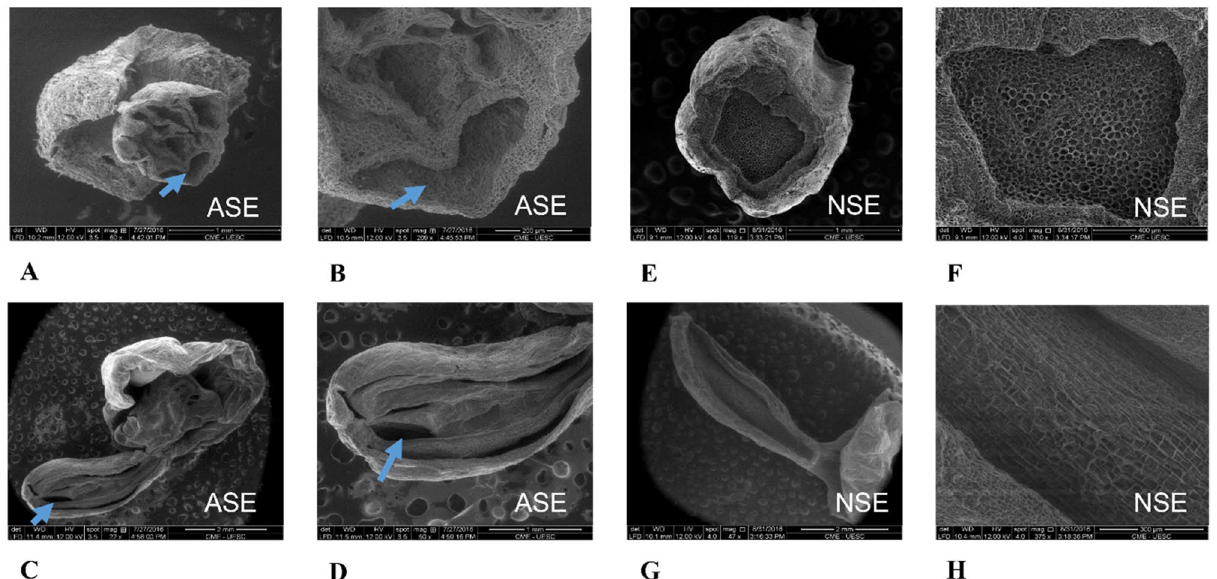
Figure 2. Morphological comparison between normal and abnormal somatic embryos. Scanning electron microscopy of AT4 SE transverse ( A,B ) and longitudinal cuts with detail, where it is observed cavities formation along of their body in these kinds of abnormal SE ( C,D ). Scanning electron microscopy of normal SE transverse ( E,F ) and longitudinal cuts with detail, in difference, normal SE do not have cavities formation in their bodies ( G,H ). Scale bar in the Figures ( A,E,D ) 1 mm; ( C,G ) 2 mm; ( B ) 200 µm; ( F ) 400 µm; ( H ) 300 µm. Blue arrows showing cavities formation in abnormal SE (ASE). NSE normal